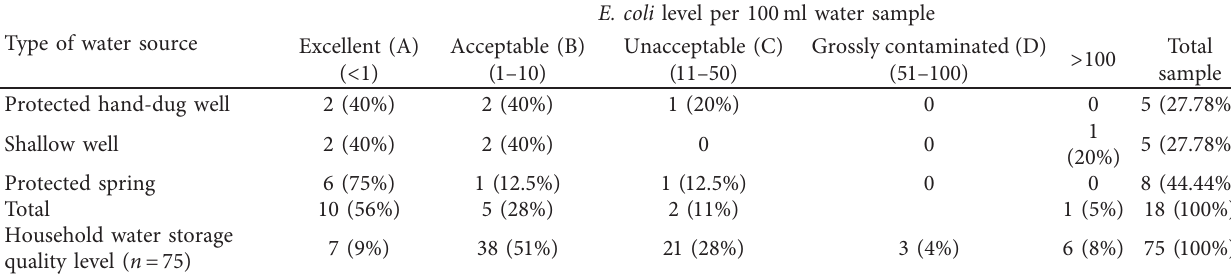
Table 5: Water quality level for the sources and household